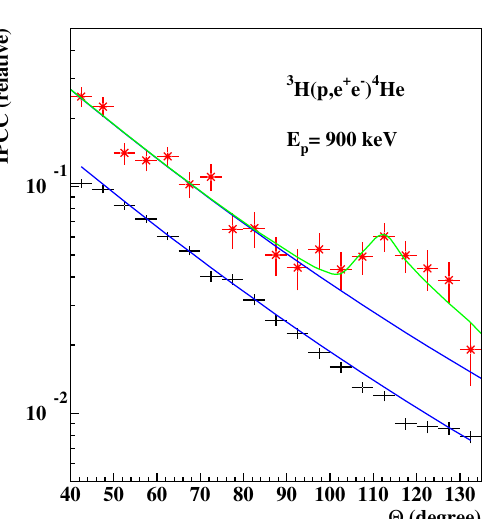
Figure 4. Top figure: summed energy spectra from di ff erent telescope pair angles: for telescopes 120 ◦ apart is shown in red, and in black for telescopes 60 ◦ apart, which are used as a back- ground measurement. Bottom figure: measured energy sum from e + e − pairs originated from the 21 MeV 4 He state decay; the back- ground coming from the target was subtracted, but not the con-